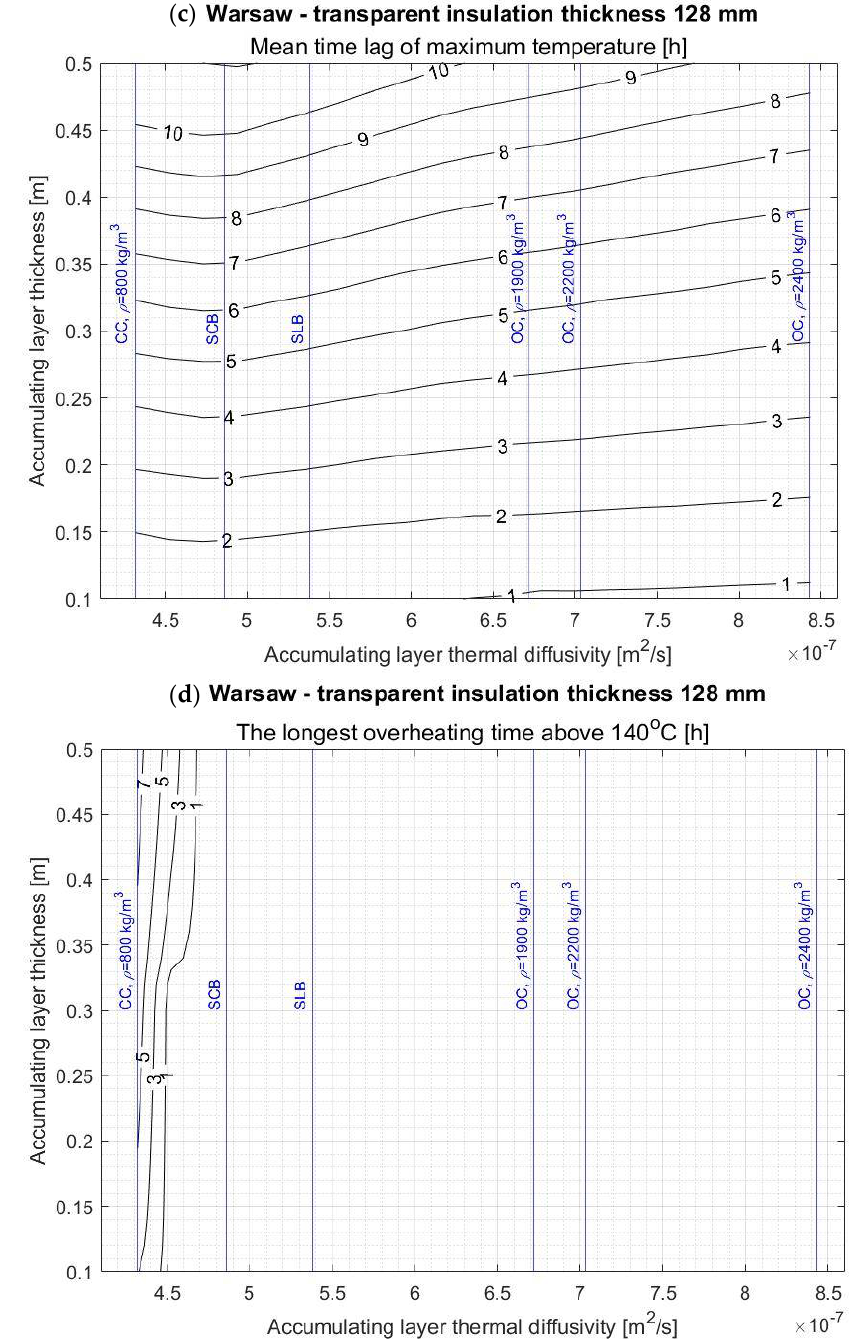
Figure 7. Contour graphs characterizing the SW basic parameters in a function of AL thermal diffusivity and thickness for the whole heating season: ( a ) the heat balance of the SW’s unit area, ( b ) the heating time, ( c ) the mean time lag of the maximum temperature on the absorber and SW’s internal surface during the day, ( d ) the longest overheating time above 140 °C in the TI. TI thickness: 128 mm. Location: Warsaw.